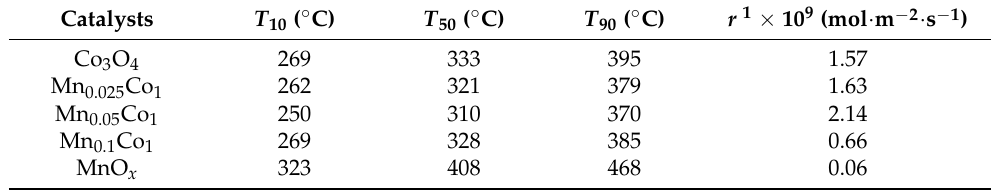
Table 2. Catalytic activities over the Co 3 O 4 , Mn x Co 1 ( x = 0.025, 0.05, and 0.1), and MnO x catalysts.